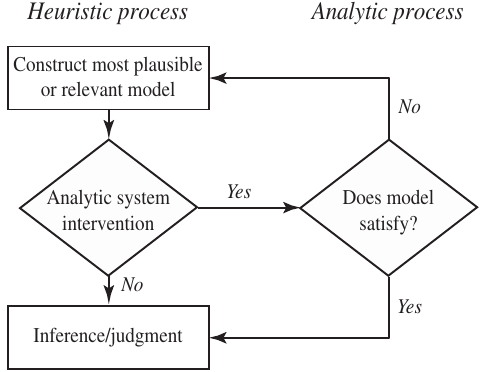
FIG. 2. A diagram illustrating interactions between the heuristic and analytical processes